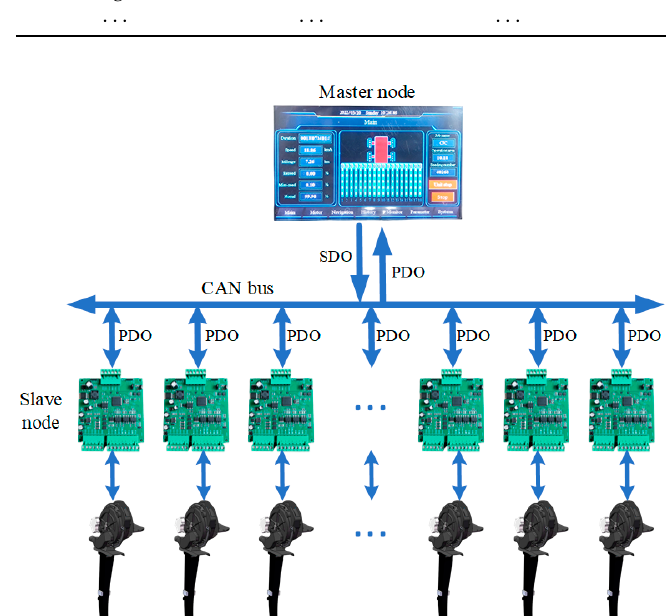
Figure 5. CAN bus data transmission